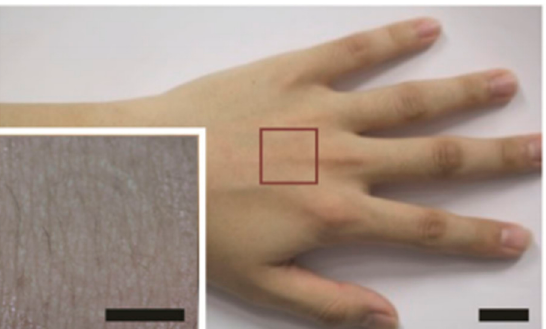
Figure 10. A transparent wireless sensor attached to human skin. Scale bar: 1 cm (inset: closeup image of the device. Scale bar: 0.5 cm) Figure reproduced with permission from Kim et al. [89]. Copyright Wiley-VCH GmbH.